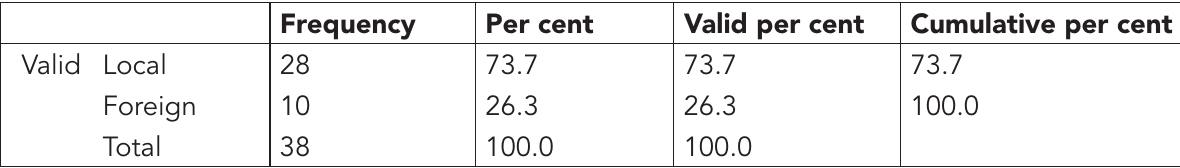
Table I: Distribution of local and foreign